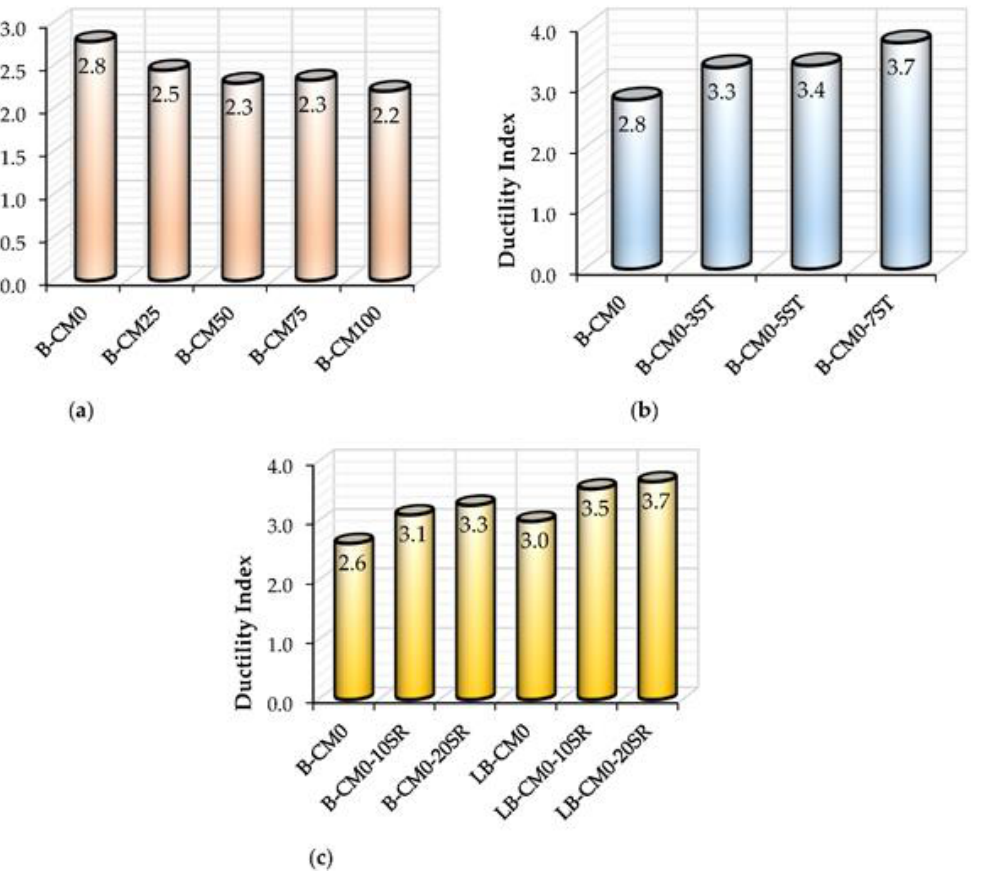
Figure 15. Ductility index (DI) of tested specimens: ( a ) Effects of varied concrete strength; ( b ) effects of steel strips; ( c ) Effects of connectors distances.